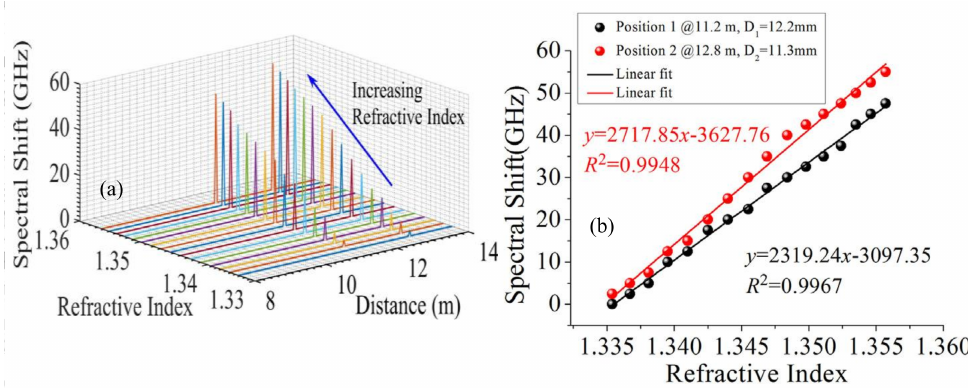
Figure 30. ( a ) Relationship between local RBS shifts and distance at various RIs. The locations of two macro-bending SMF are 12.2 mm and 11.3 mm, respectively. ( b ) The RI measurement sensitivities curves at location of 11.2 m and 12.8 m (Reprinted from Du et al. [68] with permission of Elsevier; copyright (2017)).